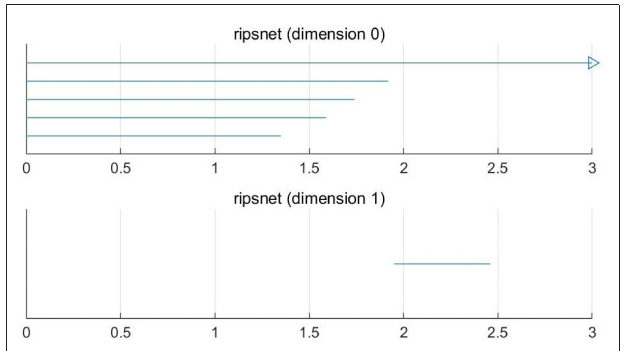
FIGURE 2 | 0-D and 1-D persistence barcodes of the point cloud data.